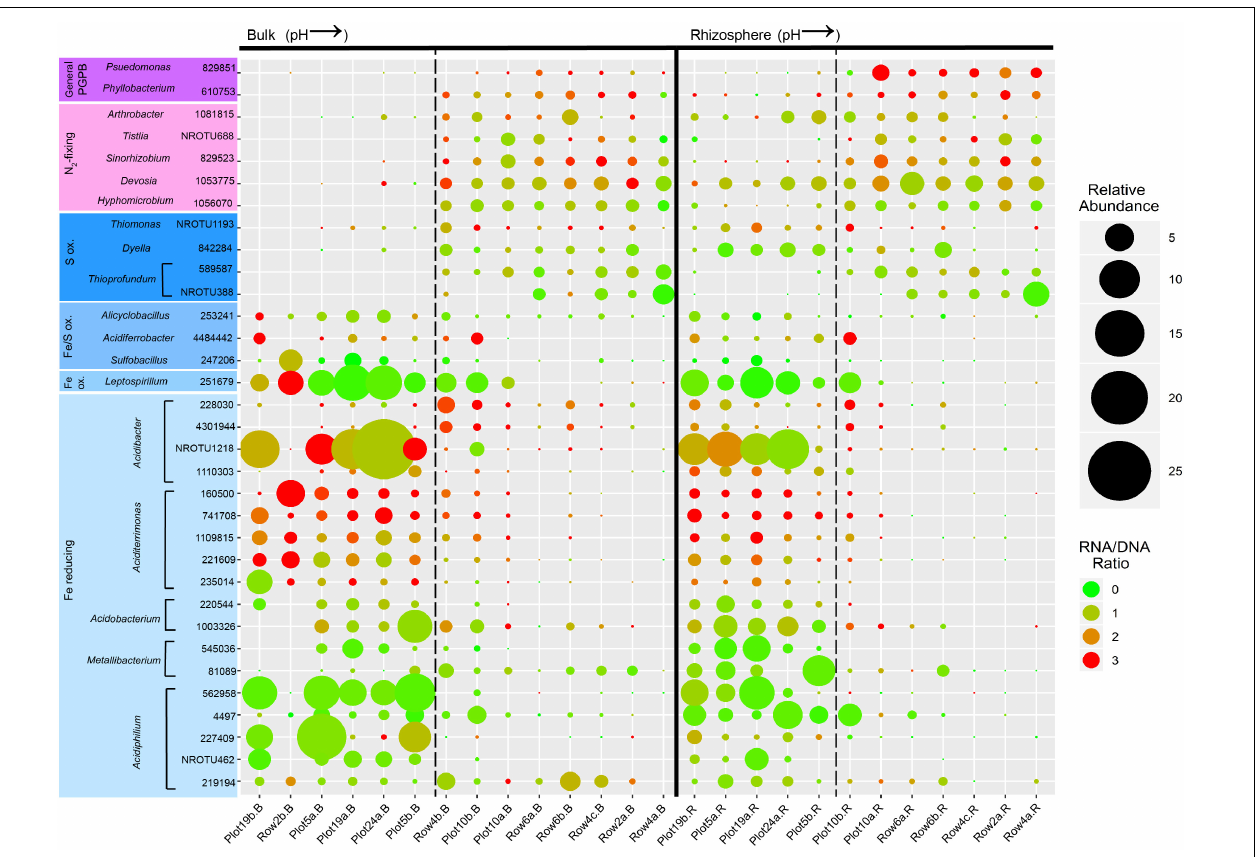
FIGURE 4 | Bubble plot showing the relative abundance (depicted by size) and activity (depicted by color) of the most abundant OTUs present in the bulk and rhizosphere of buffalo grass that are putative plant-growth promoting, N 2 -fixing, S-oxidizing, Fe-oxidizing, and Fe-reducing bacteria. Putative functions are based on the known function of the closest BLAST database match for each OTU. Samples are ordered in ascending pH of bulk (on the left) and rhizosphere (on the right). The dashed lines represent pH 4. PGPB, plant growth-promoting bacteria.